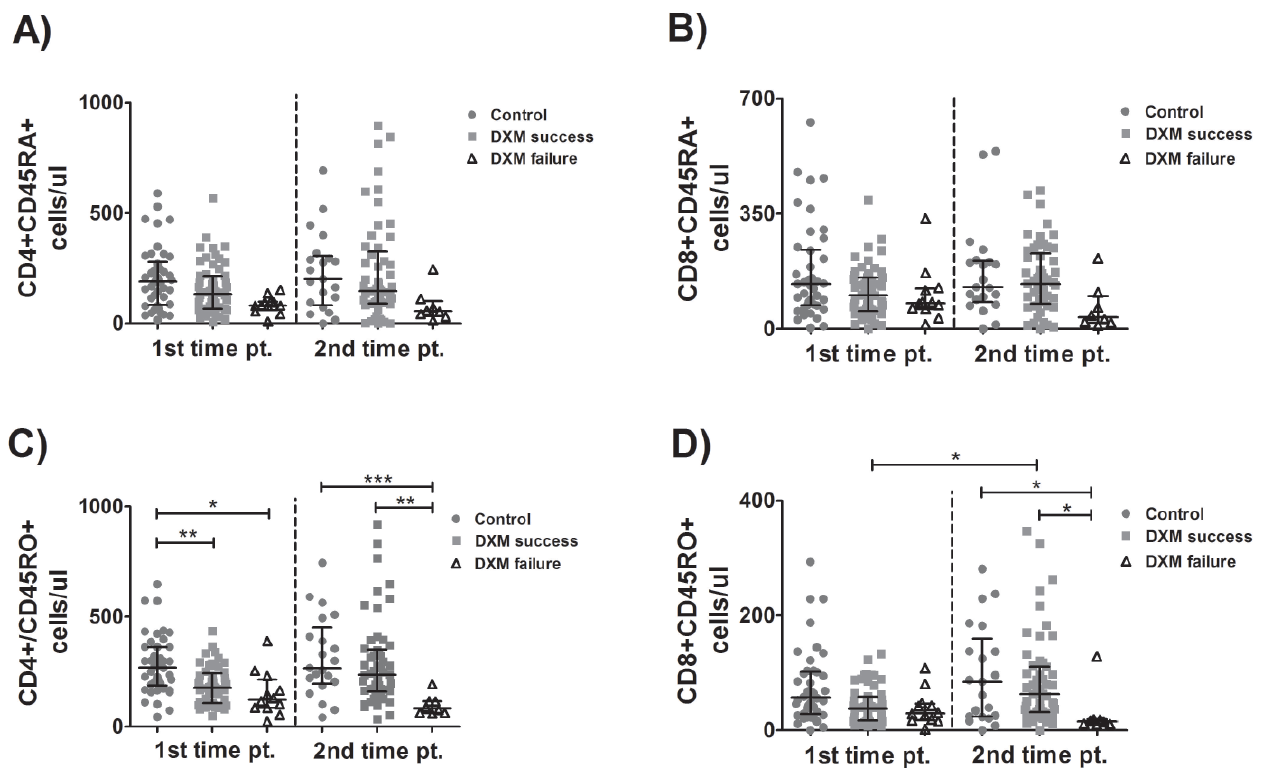
Figure 2. Kinetics of naïve and memory lymphocytes. Lymphocyte subpopulations were evaluated over time in blood samples from patients with COVID-19 who received (or not) treatment with dexamethasone. Naïve CD4+ ( A ), CD8+ ( B ) T-lymphocytes and memory CD4+ ( C ) and CD8+ ( D ) T-lymphocytes were determined with flow cytometry. Multiple comparisons were made using Kruskal–Wallis with Dunn’s post-hoc tests. Comparisons between the two groups were made with Student’s T -test or the Mann–Whitney U-test as indicated. DXM: Dexamethasone. p -values < 0.05 were considered significant. * p <0.05, ** p <0.01, *** p <0.001.